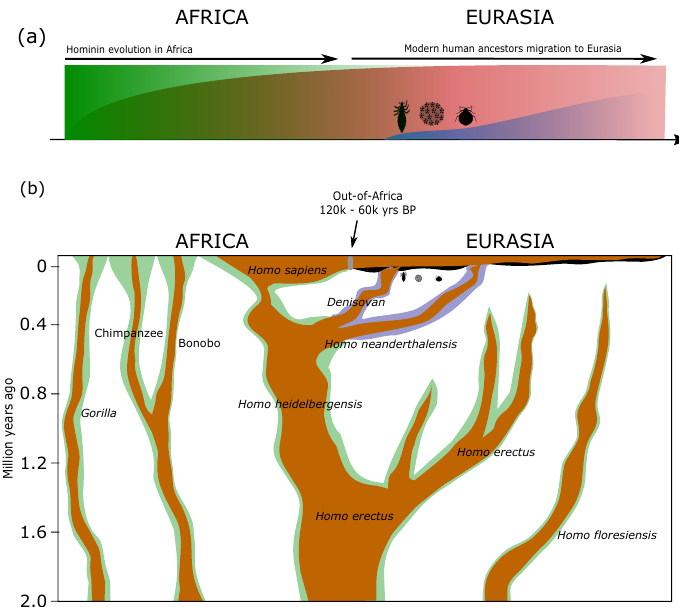
Figure 2. Human pathogen origin and transmission scenario between modern human ancestors, other hominin groups, and the African great apes. ( a ) Schematic diagram as a function of time ( x -axis) of the human pathogen presence originating from Africa (e.g., human papillomavirus (HPV), herpes simplex virus (HSV), and human immunodeficiency virus (HIV) [29,30,33] depicted in green) and evolving among modern humans migrating out-of-Africa (red color), with additional transmission between modern humans and other hominins in Eurasia (e.g., HPV [1], HSV [42], lice [44], and bed bugs depicted as three icons and subsequent prevalence in blue color). Hence, we highlight that, following the out-of-Africa migration of modern humans, sexual transmission from Neanderthals or other hominin groups likely introduced certain HPV, HSV, and ectoparasitic pathogens to modern humans, many of which are still prevalent today. ( b ) The majority of modern human pathogens emerged in Africa (illustrated as green shades along the corresponding Hominin and great ape evolutionary tree [29,30,33]), where they were transmitted between ancestral hominin groups and the African great apes, and further codiverged and dispersed outside Africa with the corresponding ancestral hominin groups: evolution of Neanderthal and Denisovan populations exclusively in Eurasia with their corresponding pathogens (illustrated in blue color and with three icons ca. 800–400 kya [48–51]), also leading to host-switch events with modern human ancestors after modern human out-of-Africa migration and admixture, ca. 120–60 kya [48,49]. Pathogens associated with modern humans outside Africa are illustrated in blackshades along the corresponding modern human dispersals. Hominin evolution with wavy branch edges indicating presumed population fluctuations in time was modified from